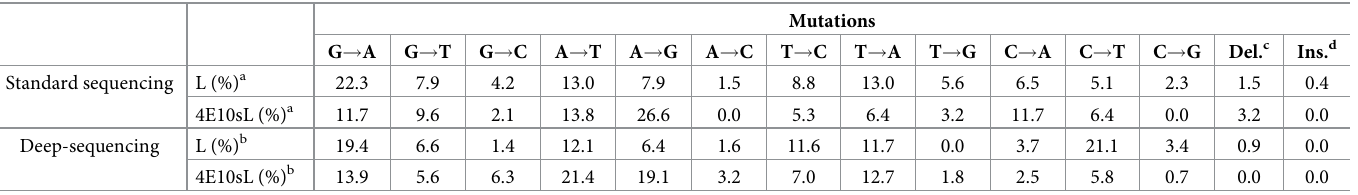
Fig 1. Rapid Immunogen Selection (R.I.S.) method. (A) Random mutations were introduced into HIV-1 env AC10_29 sequence by mutagenic PCR. (B) A library of chimeric HIV virions was generated by cloning randomly mutated envelopes into pNL4-3 using XbaI and NotI restriction sites and transient transfection into 293T cells. (C) Virion library was used in an enhanced virion capture assay modified from Leaman et al as indicated in the Materials and Methods section (41). (D) RNA from captured virions was extracted, retrotranscribed into DNA and amplified by nested RT-PCR. (E and B) A new library of chimeric virions was generated by transient transfection of the env amplified product out of captured virions and cloned into NL4-3 proviral DNA.